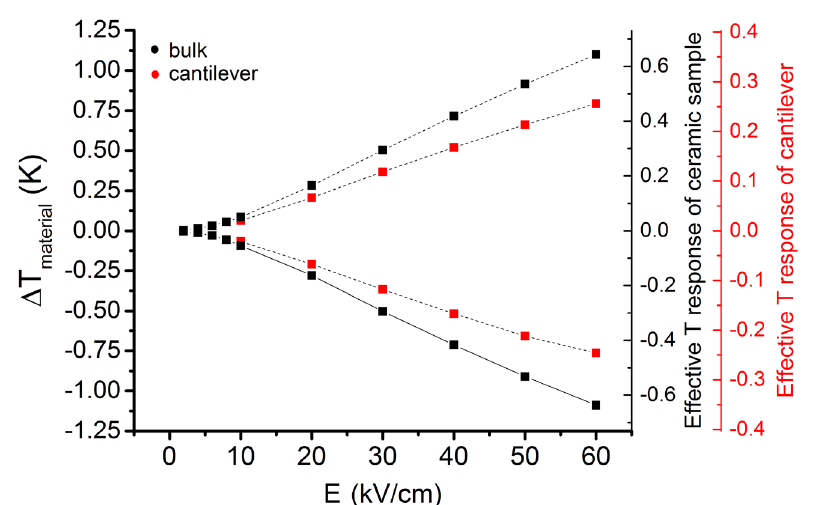
Figure 5. EC effect of bulk ceramics (black) and cantilevers (red). Left vertical axis shows the corrected values, i.e., materials response (Δ T material ), while the right axis displays the effective temperature change (note two scales for the ceramic and cantilever samples).